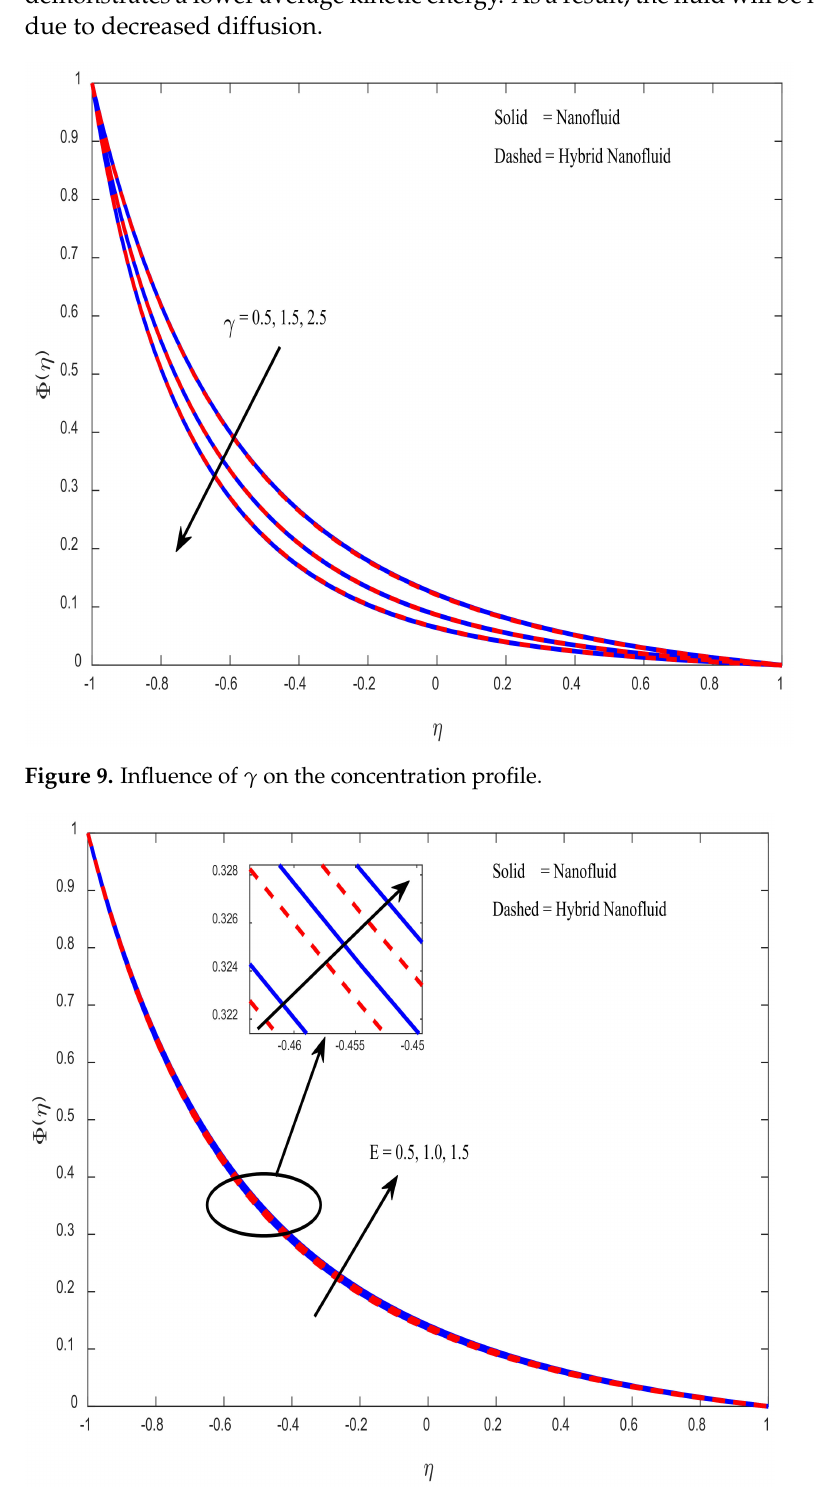
Figure 10. Influence of E on the concentration